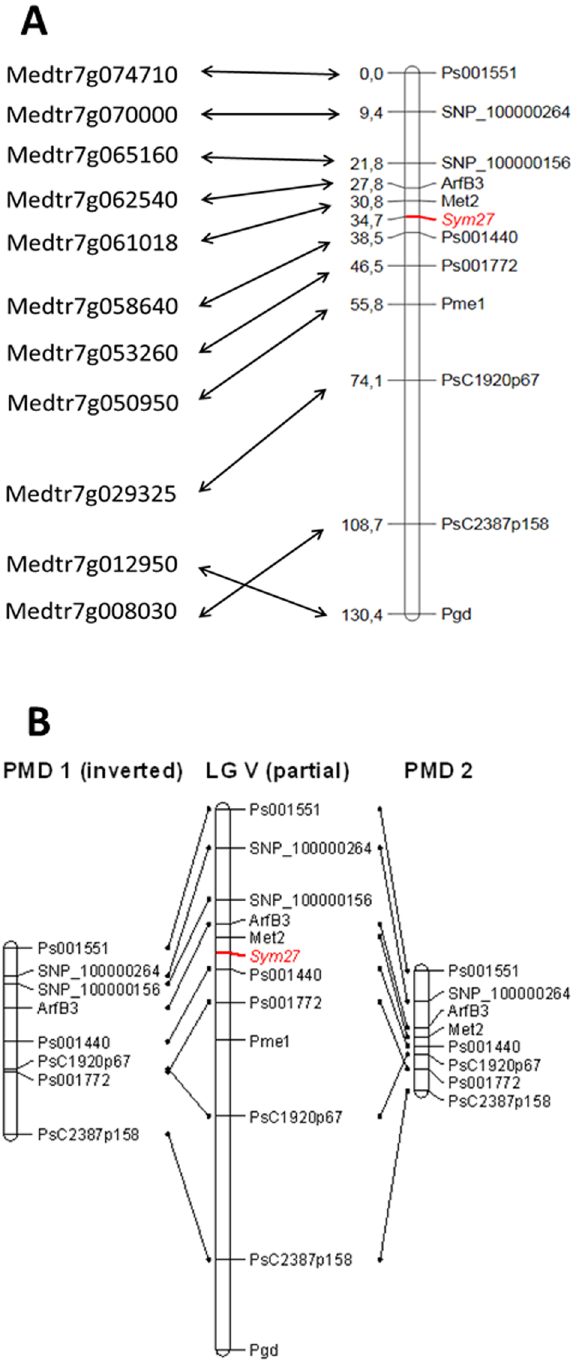
Fig 6. Localization of Sym27 gene in relation to gene-based markers. A— M . truncatula genes homologous to pea markers used for Sym27 mapping(right) and pea geneticmap with Sym27 position (left). B—Order of markers on the resultingmap (center), PMD1 (left) and PMD2 (right).